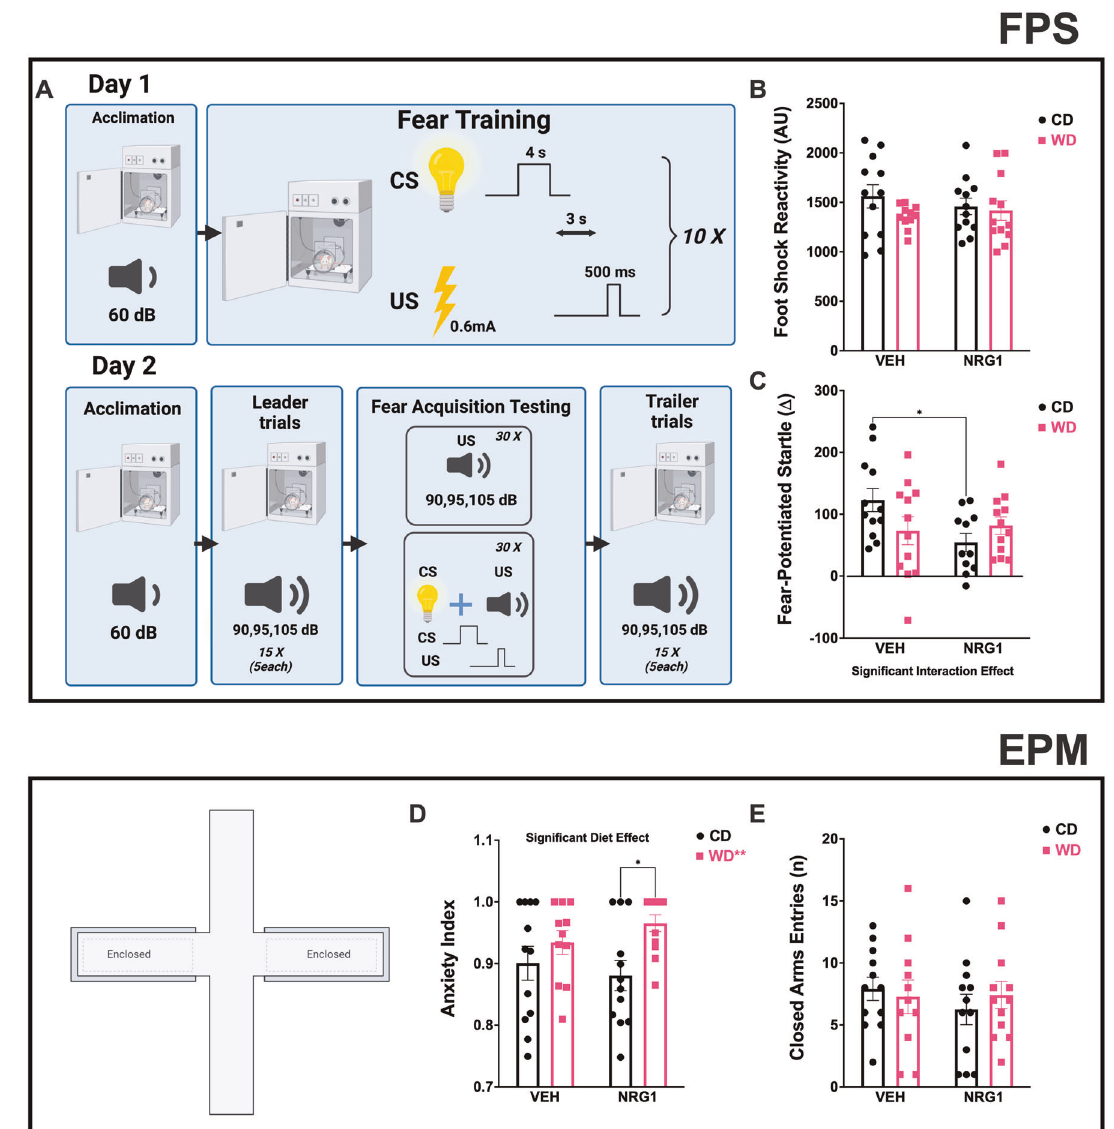
Fig. 2 Behavioral phenotypes associated with early access to an obesogenic diet and prolonged NRG1 administration. A Schematic illustration of trace FPS protocol. B Startle reactivity to the foot shocks was not affected by treatment [ F (1, 43) = 0.05, p = 0.82] or diet [ F (1, 43) = 1.82, p = 0.19]. C Fear potentiated-startle (FPS) responses were determined from trace conditioning protocol and showed a decrease in FPS in CDN rats relative to CDV (interaction: [ F (1, 43) = 4.57, p = 0.038], post hoc, p = 0.021). D Elevated-plus maze (EPM) anxiety index was affected by the diet [ F (1, 43) = 7.27, p = 0.009]. WDN rats demonstrated higher anxiety indices in the EPM when compared to CDN ( p = 0.017). E Number of closed arms entries in the EPM was not affected by treatment [ F (1, 43) = 0.434, p = 0.514] or diet [ F (1, 43) = 0.051, p = 0.822]. For all behaviors: sample size = 12 rats/group (before outlier testing). 0.74, p = 0.42]; diet x drug: [ F (1,8) = 3.30, p = 0.11]; ROI x diet x drug: microglial density (solidity) as a measure of cell size based on area demonstrated that the WD signi fi cantly decreased microglial [ F (1,8) = 2.76, p = 0.14]), suggesting higher cellular complexity. density in the right CA1 sub fi eld (Fig. 4B) (ROI: [ F (1,8) = 1.06, p = The span ratio is a measure that describes the cell shape (or form factor) and is based on the ratio of length and height of the 0.33]; diet : [ F (1,8) = 6.82, p = 0.031]; treatment: [ F (1,8) = 0.01, p = Convex Hull area occupied by the cell [77]. The higher the span 0.93]; ROI x diet: [ F (1,8) = 0.82, p = 0.39]; ROI x treatment: [ F (1,8) = ratio, the less difference in area between soma and processes 0.04, p = 0.84]; diet x drug: [ F (1,8) = 2.17, p = 0.18]; ROI x diet x drug: (elongated morphotype). The span ratio was signi fi cantly [ F (1,8) = 2.71, p = 0.14]). This fi nding suggests a less compact/more increased in the right CA1 region of rats receiving the exogenous rami fi ed microglia phenotype. Microglial lacunarity is a measure of NRG1 (Fig. 4C) ( ROI : [ F (1,8) = 1.43, p = 0.27]; diet: [ F (1,8) = 0.41, p = heterogeneity that re fl ects sensitive changes in particular features such as soma size relative to process length [78]. We found that 0.54]; treatment: [ F (1,8) = 15.43, p < 0.004]; ROI x diet: [ F (1,8) = 6.88, lacunarity was signi fi cantly increased in the right CA1 sub fi eld of p = 0.03]; ROI x treatment: [ F (1,8) = 29.31, p = 0.001]; diet x drug: rats that consumed an obesogenic WD (Fig. 4B) (ROI: [ F (1,8) = 0.21, [ F (1,8) = 1.63, p = 0.24]; ROI x diet x drug: [ F (1,8) = 0.11, p = 0.75]). p = 0.65]; diet: [ F (1,8) = 12.09, p = 0.008]; treatment: [ F (1,8) = 0.93, p Circularity is a measure of shape (soma thickness). High circularity = 0.36]; ROI x diet: [ F = 2.77, p = 0.13]; ROI x treatment: [ F = values are associated with round sphere shapes, suggesting a (1,8) (1,8) Translational Psychiatry (2022)